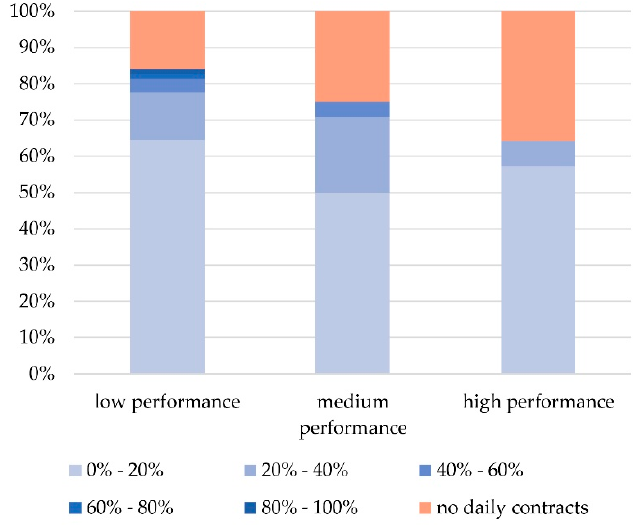
Figure 7. Shares of profitability associated with daily contracts by performance category (last six months).